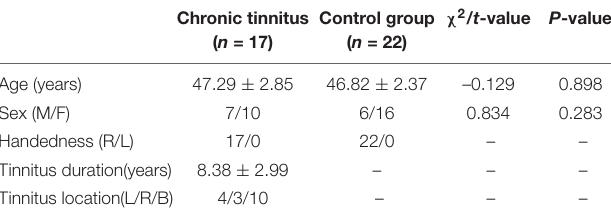
TABLE 1 | The demographic data of chronic tinnitus patients and normal